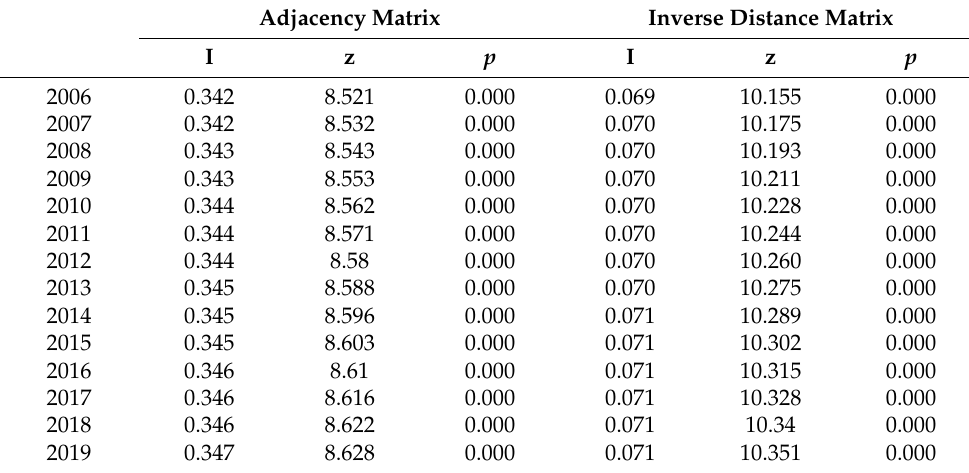
Table 9. Global Moran’s I from 2006 to